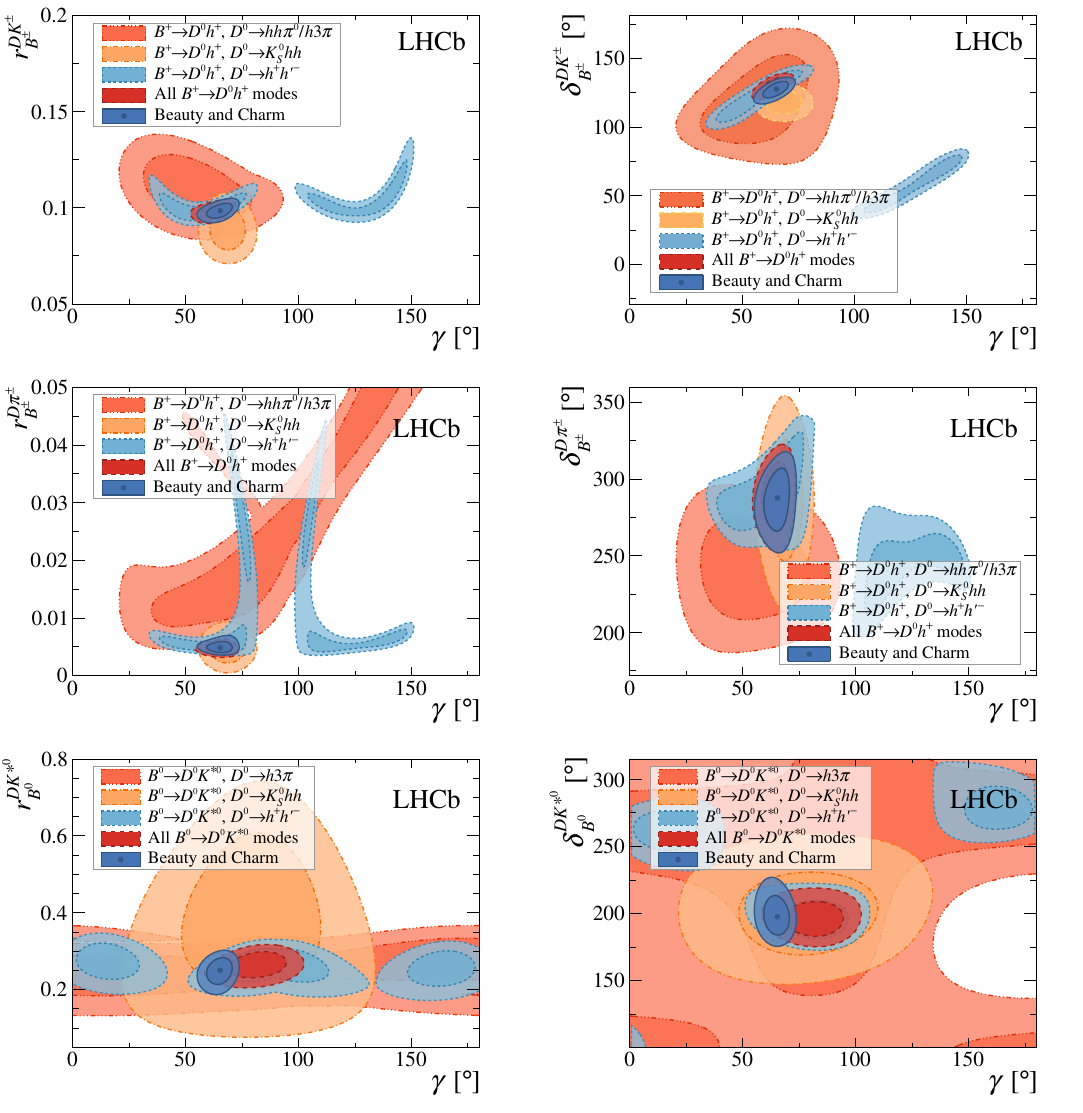
Figure 4 . Profile likelihood contours for the beauty decay parameters versus γ , showing the breakdown of sensitivity amongst different sub-combinations of modes. The contours indicate the 68.3% and 95.4% confidence